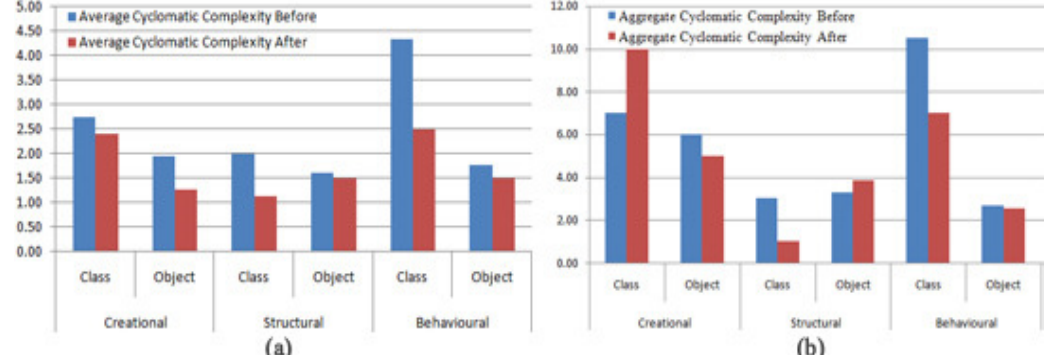
FIG. 6. IMPACT ON CYCLOMATIC COMPLEXITY FOR DIFFERENT CATEGORIES OF DESIGN PATTERNS (A) AVERAGE CYCLOMATIC COMPLEXITY (B) AGGREGATE CYCLOMATIC COMPLEXITY